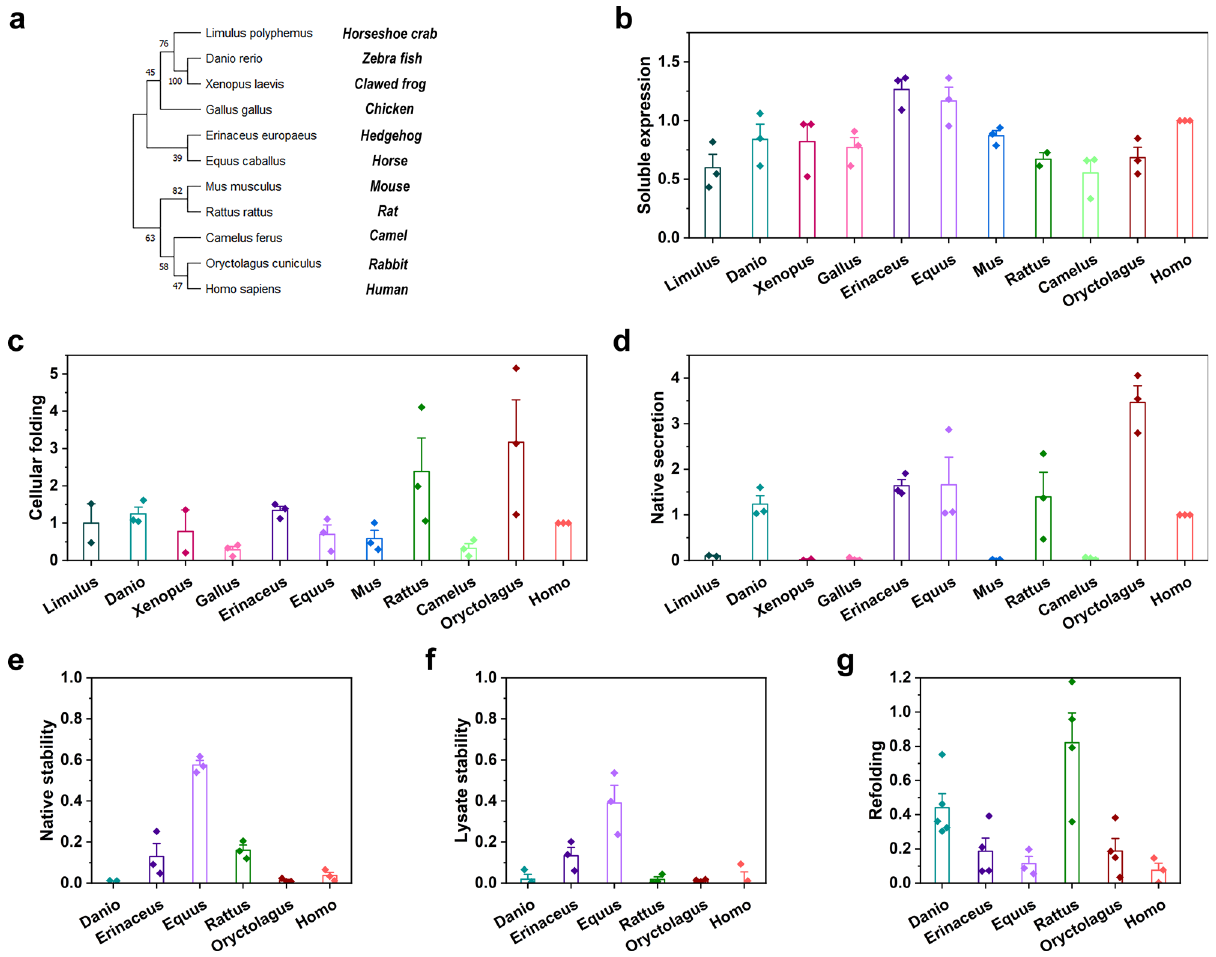
Fig. 4 Structural constraints show little effect in shaping CRP evolution. a Phylogenetic tree of CRP amino acid sequences from 11 species was constructed by the Neighbor-Joining method using MEGA-X 65 . The percentage of replicate trees in which the associated taxa clustered together in the bootstrap test (500 replicates) are shown next to the branches. The tree is drawn to scale, with branch lengths in the same units as those of the evolutionary distances used to infer the phylogenetic tree. CRP of 11 species was expressed in E. coli cells, and their expression levels in supernatants of cell lysates ( n = 3 independent experiments) ( b ), PC-binding activities in supernatants of cell lysates ( n = 2 independent experiments for Limulus and Xenopus; n = 3 independent experiments for other species) ( c ), and culture media ( n = 2 independent experiments for Limulus and Xenopus; n = 3 independent experiments for other species) ( d ) were determined with immunoblotting or ELISA. The obtained values were then normalized to that of human CRP. CRP of 6 species with extracellular PC-binding activities was further examined with their thermal stability in culture media ( n = 3 independent experiments) ( e ) and cell lysates ( n = 3 independent experiments) ( f ) upon heating to 70 °C, and their capacities to refold in culture media after urea treatment ( n = 3 independent experiments for Equus and Homo; n = 4 independent experiments for other species) ( g ). These measured parameters showed little evolutionary correlation among the 11 nodes of CRP. Data are presented as mean ±